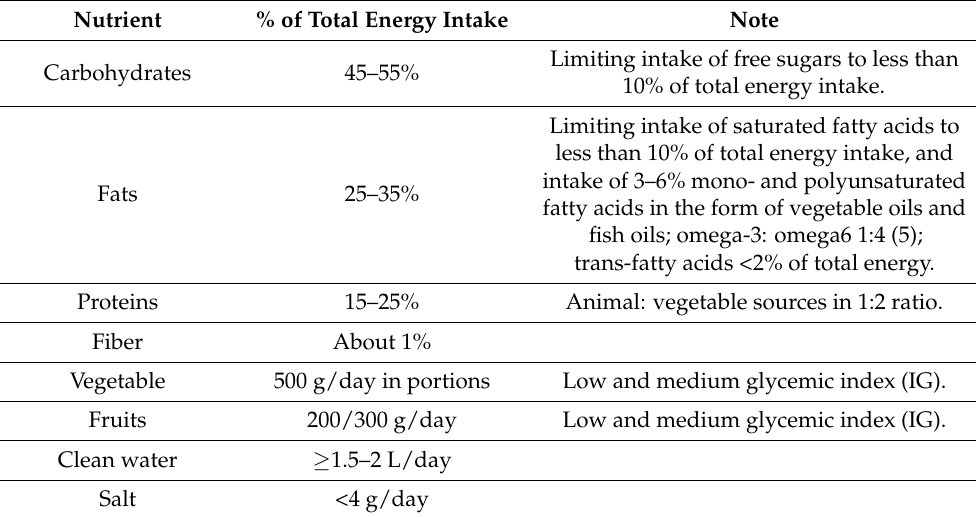
Table 1. General diet composition employed in the present study and assembled according to healthy nutrition recommendations of the Polish National Food and Nutrition Institute and the World Health Organization (WHO). Nutrient % of Total Energy Intake Note Limiting intake of free sugars to less than Carbohydrates 45–55% 10% of total energy intake. Limiting intake of saturated fatty acids to less than 10% of total energy intake, and intake of 3–6% mono- and polyunsaturated Fats 25–35% fatty acids in the form of vegetable oils and fish oils; omega-3: omega6 1:4 (5); trans-fatty acids <2% of total